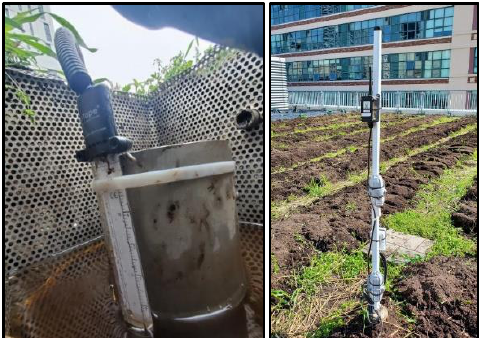
Figure 5. Sensor fixed to the drain ( left ) and node mounted on the pole ( right ).